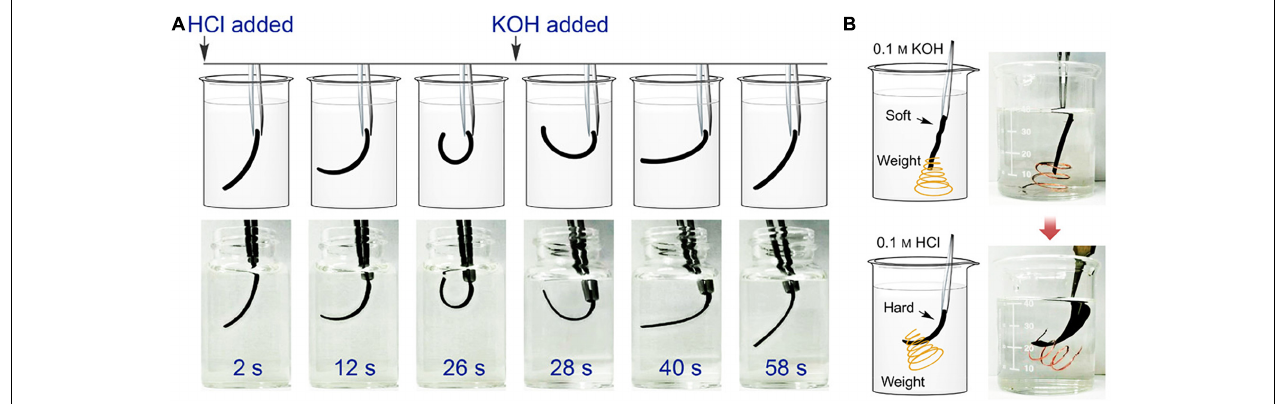
FIGURE 2 | (A) pH-responsive deformation of the lignin-based hydrogel by adding HCl and KOH solution; (B) Actuating performance of the lignin-based hydrogel for being hooked up (Dai L. et al., 2020).